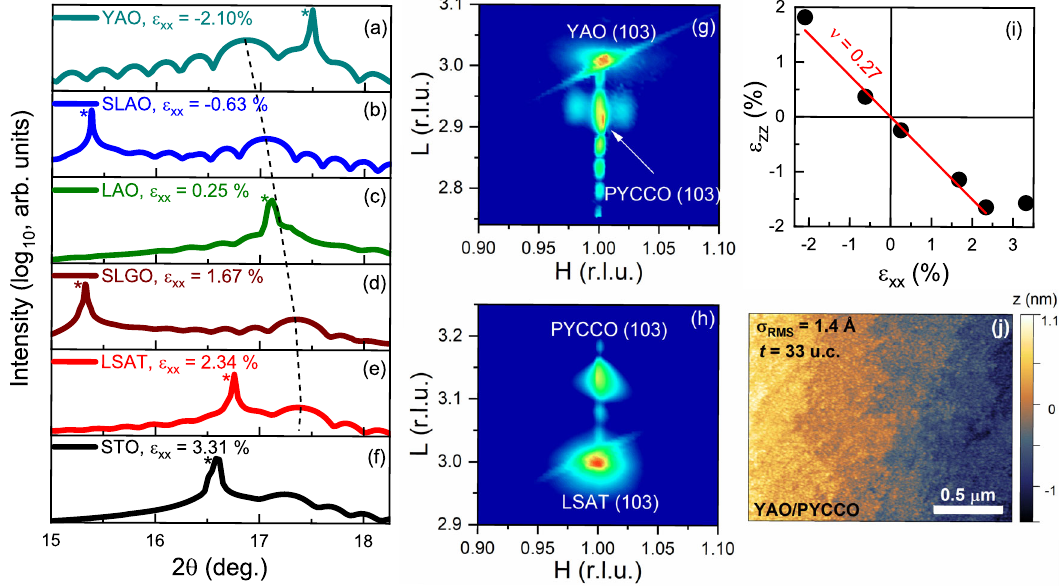
Fig. 1 | Structural characterization of (Pr 0.85 Y 0.15 ) 0.7 Ca 0.3 CoO 3- δ fi lms. Specular synchrotron X-ray diffraction (SXRD, 0.564Å wavelength) around the 002 fi lm peaksof28-to33-unit-cell-thick(Pr 0.85 Y 0.15 ) 0.7 Ca 0.3 CoO 3- δ fi lmson( a )YAO(101),( b ) SLAO(001),( c )LAO(001),( d )SLGO(001),( e )LSAT(001)and( f )STO(001)substrates (labeled with the “ in-plane strain ” , ε xx ). Substrate re fl ections are labeled “ * ” . Asymmetric SXRD reciprocal space maps around the fi lm 103 peaks (pseudocubic notation) of 28-unit-cell-thick (Pr 0.85 Y 0.15 ) 0.7 Ca 0.3 CoO 3- δ fi lms on ( g ) YAO(101) and